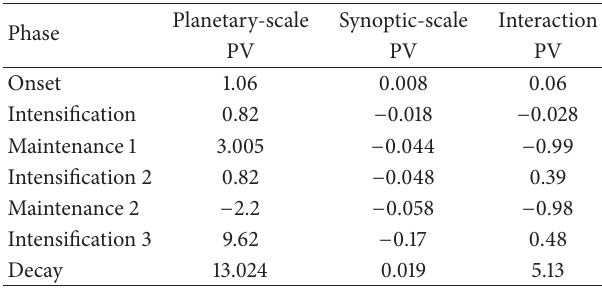
Table 2: Scale partitioned PV tendency on 315 K Surface: PV ×